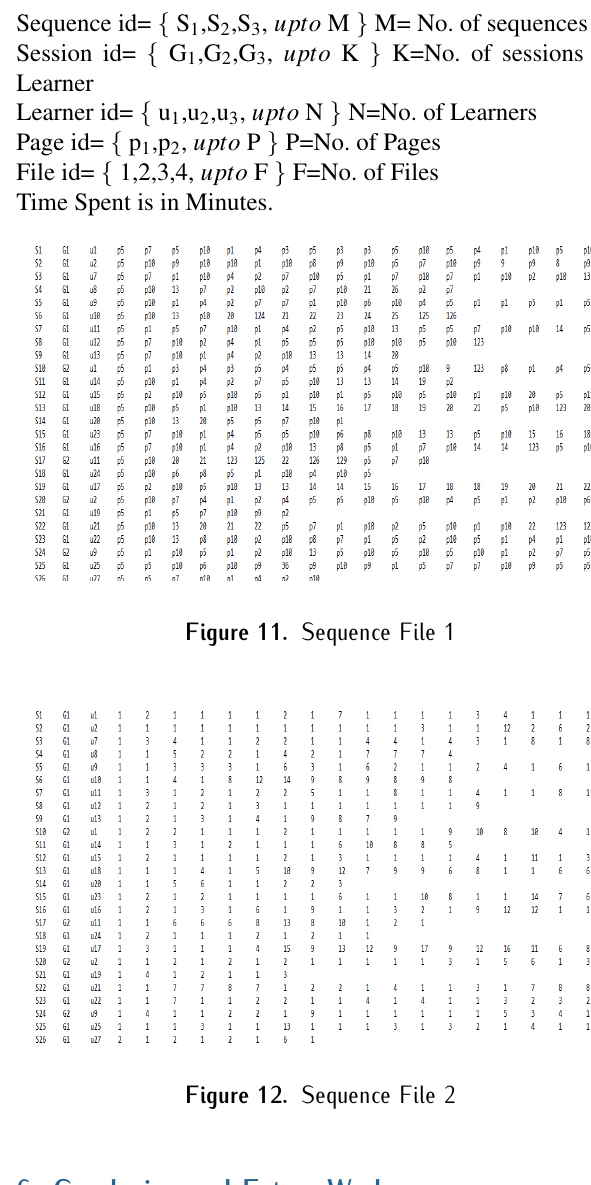
Figure 12. Sequence File